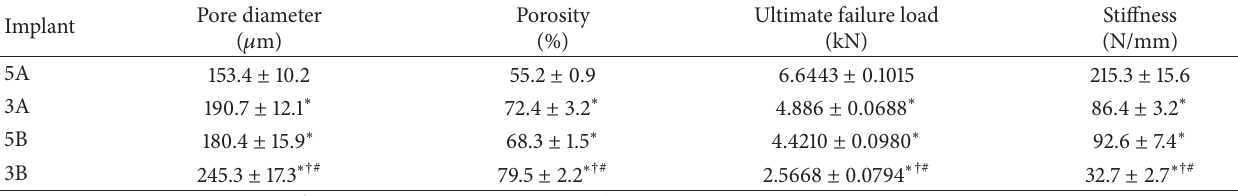
Table 1: Characterization of different PET-ALs ( n = 6, mean ±